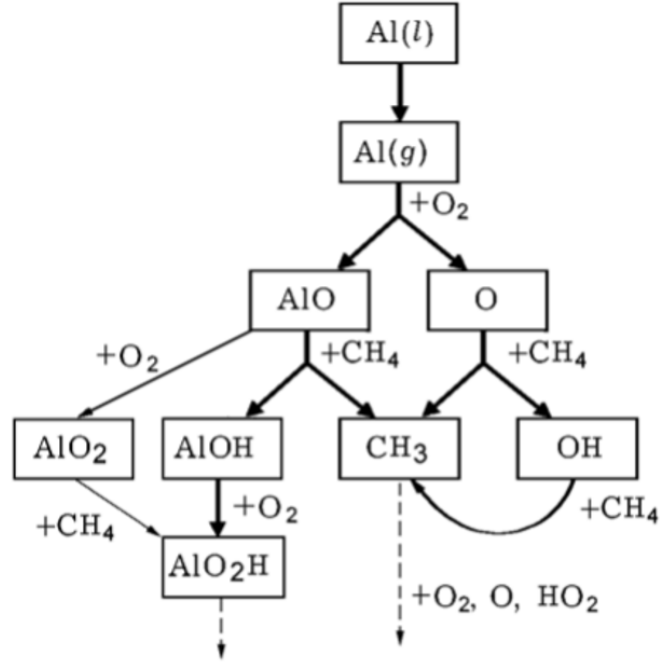
Figure 4. Hydrocarbon fuels containing aluminum particles will also have a higher flame propaga- tion velocity. The acceleration is conditioned by an increase in the rate of diffusion of active radicals, from the hot to the cold zone of the flame.